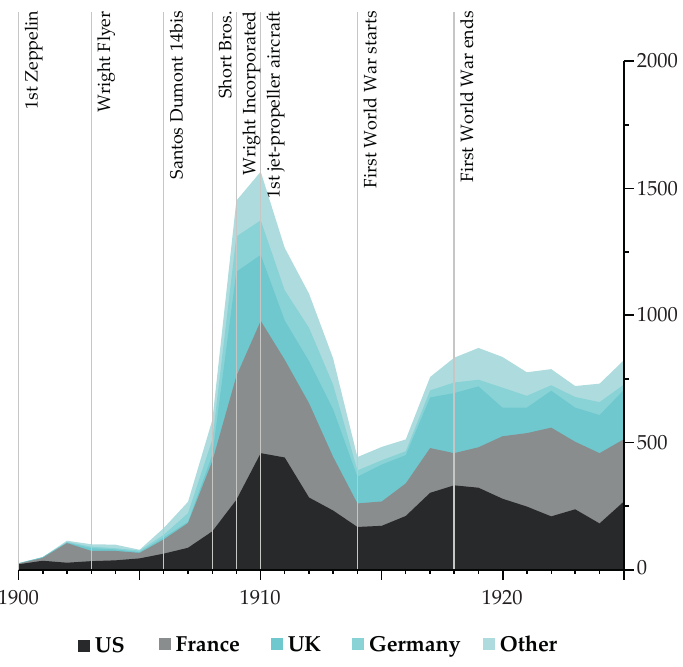
Figure 1. First patent filings by origin, 1900–1925. Between 1900 and 1970, patent filings relating to aviation tended to concentrate in the US, France, Germany, and the UK. Source: adapted from